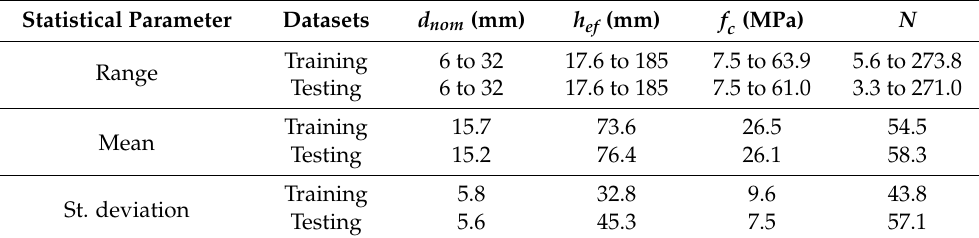
Table 2. Statistical summary of the training and testing dataset used for the model